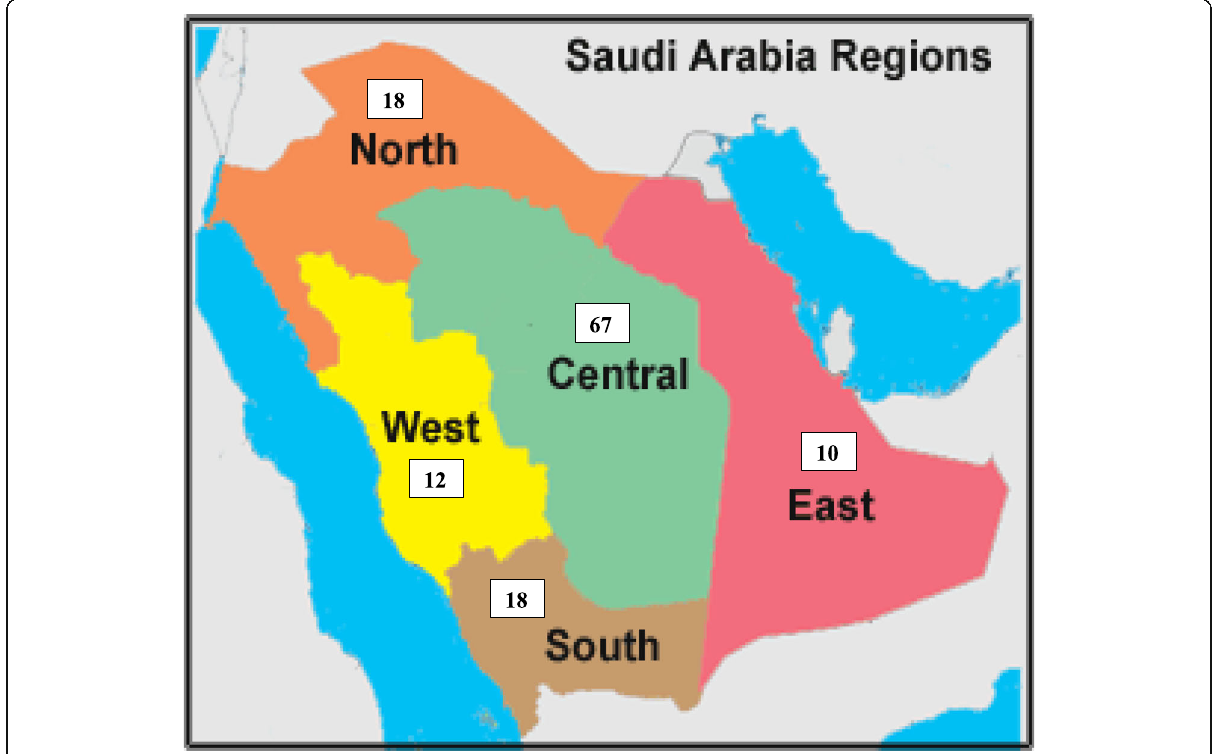
Fig. 2 Map of Saudi Arabia showing 5 geographic regions with corresponding sample sizes collected from those